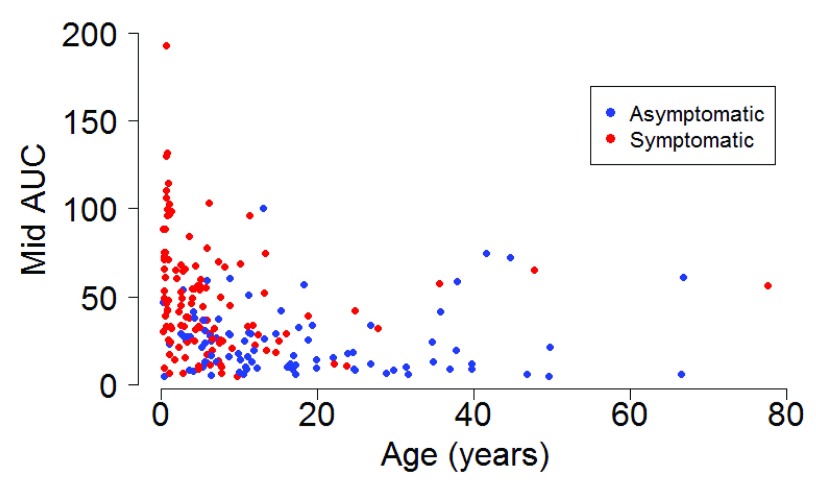
Scatter plot showing the relationship between midpoint AUC and age stratified by symptom status.